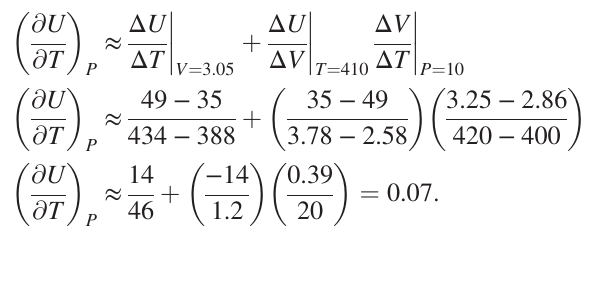
FIG. 6. One possible method for evaluating the desired partial derivative using graphical analysis